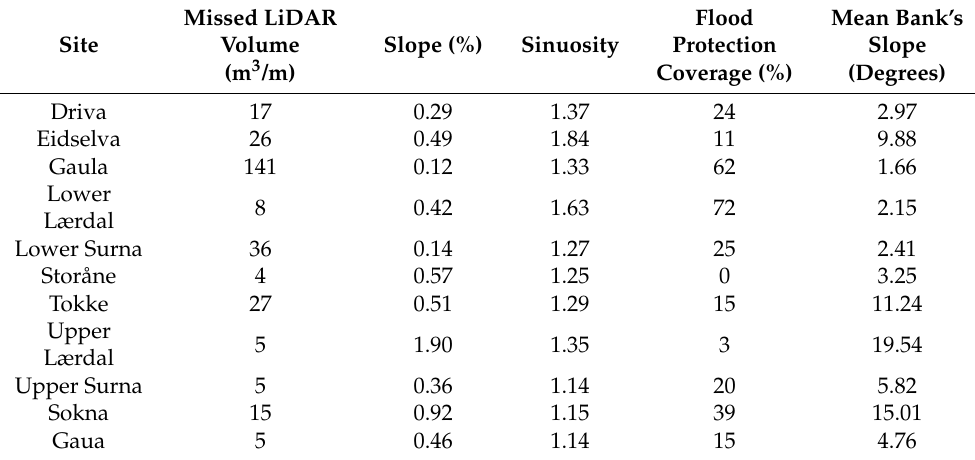
Table 3. Terrain analysis outputs for the 11